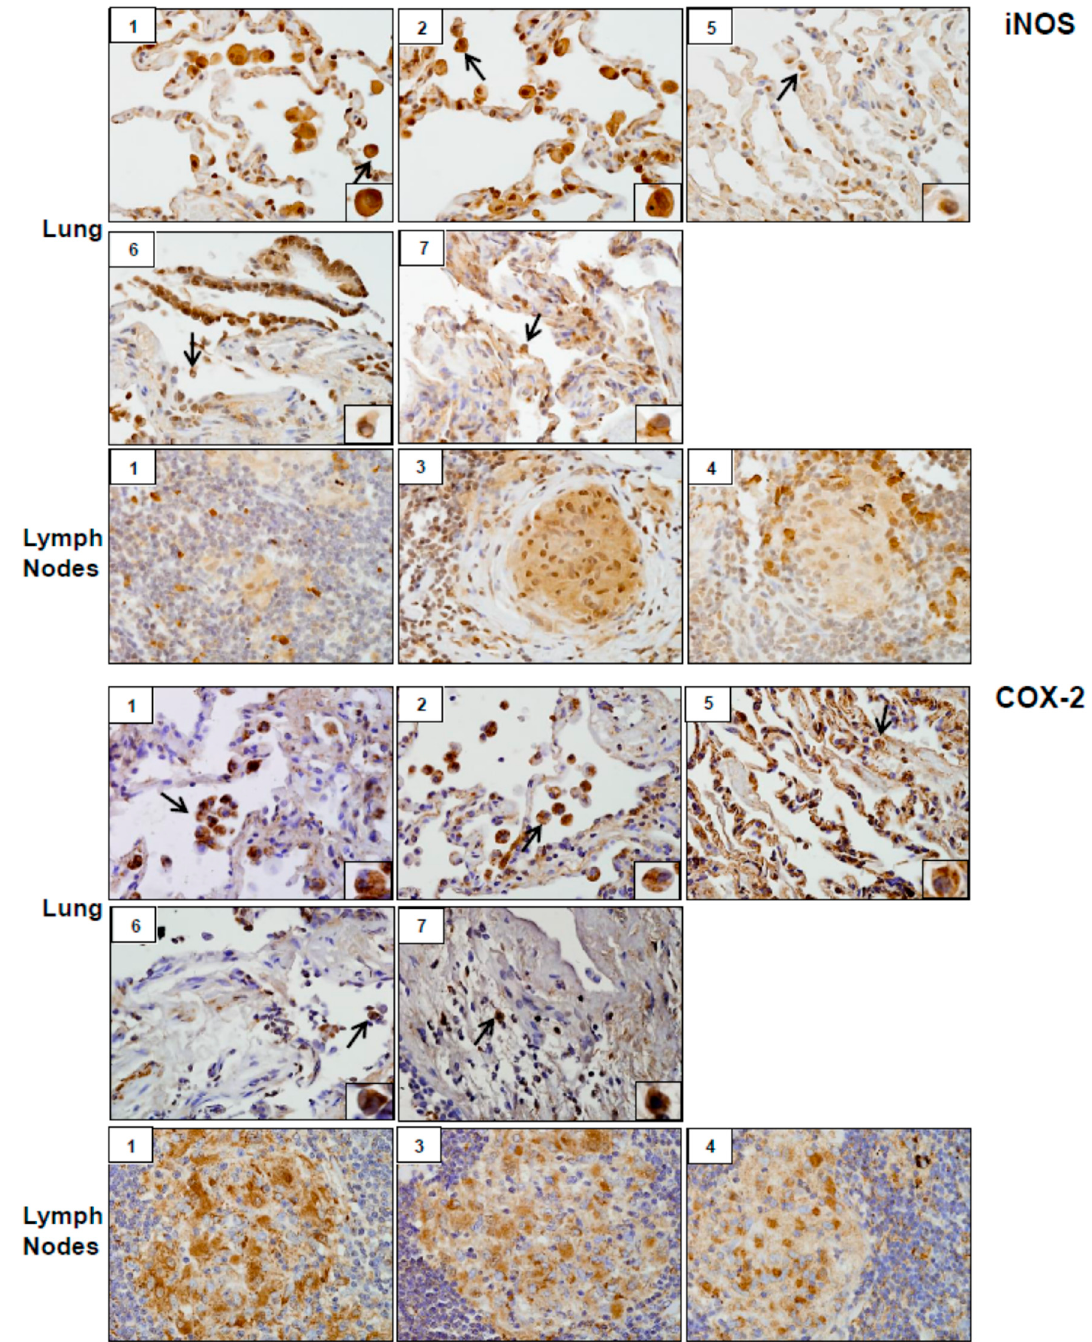
Figure 5. Inducible nitric oxide synthase (iNOS) and Cyclooxygenase (COX)-2 expression in lung and/or lymph nodes collected from WTC rescue and recovery workers. Sections were immunostained with antibody to iNOS or COX-2. Binding was visualized using a DAB peroxidase substrate kit. One representative section from each patient is shown. Inset, patient number. Magnification, 60 × ; arrows, alveolar macrophages.